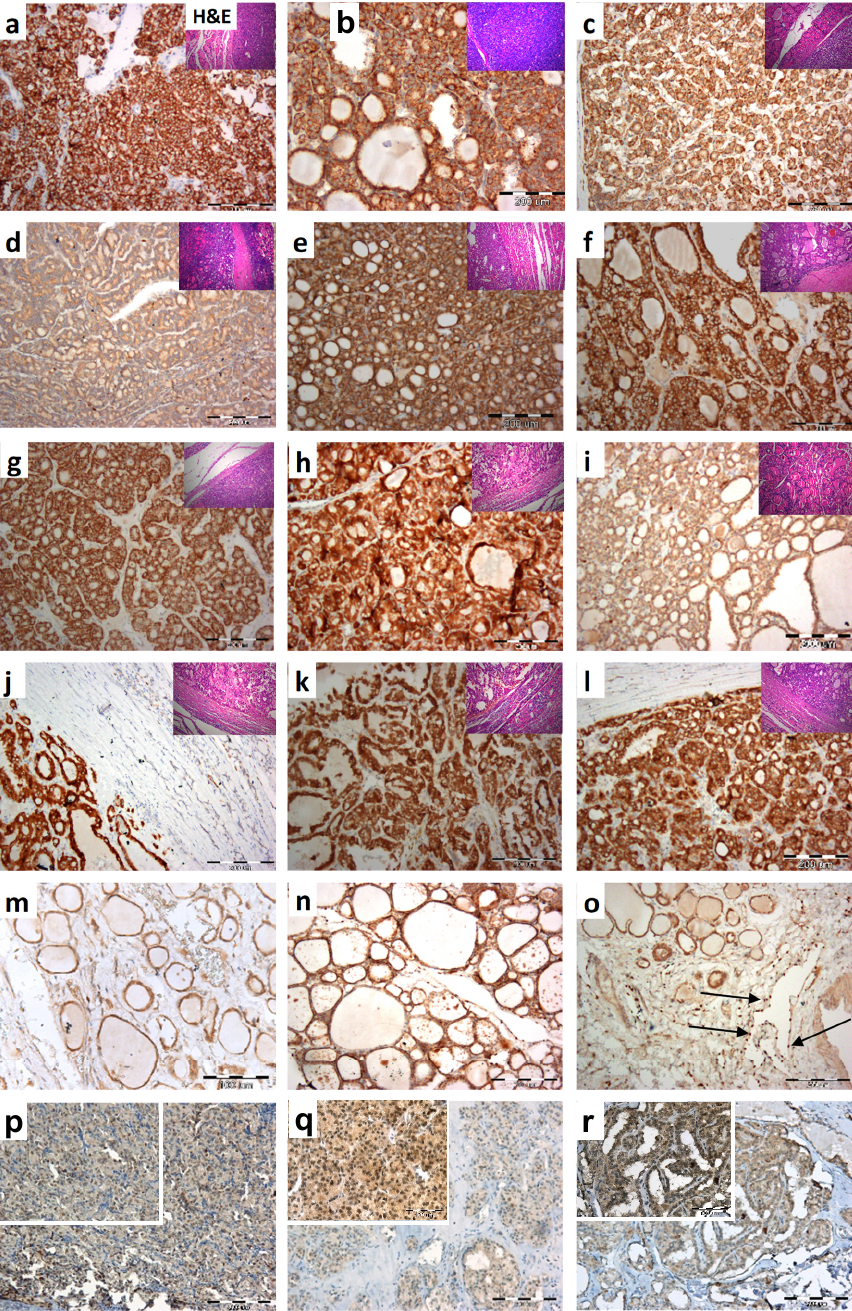
Figure 8. Analysis of PROX1 expression in human FTC tissue sections. Representative immunohistochemistry images of PROX1 expression ( a–l ) showing variable intensity of immunostaining. In the normal thyroid ( m , n ), the PROX1 labelling was mostly uniform in both